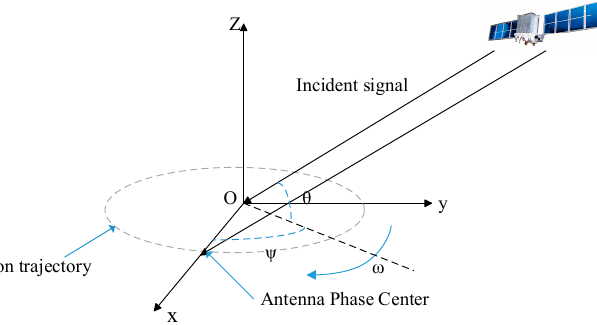
Figure 2. Rotating single-antenna carrier-phase differential detection model.